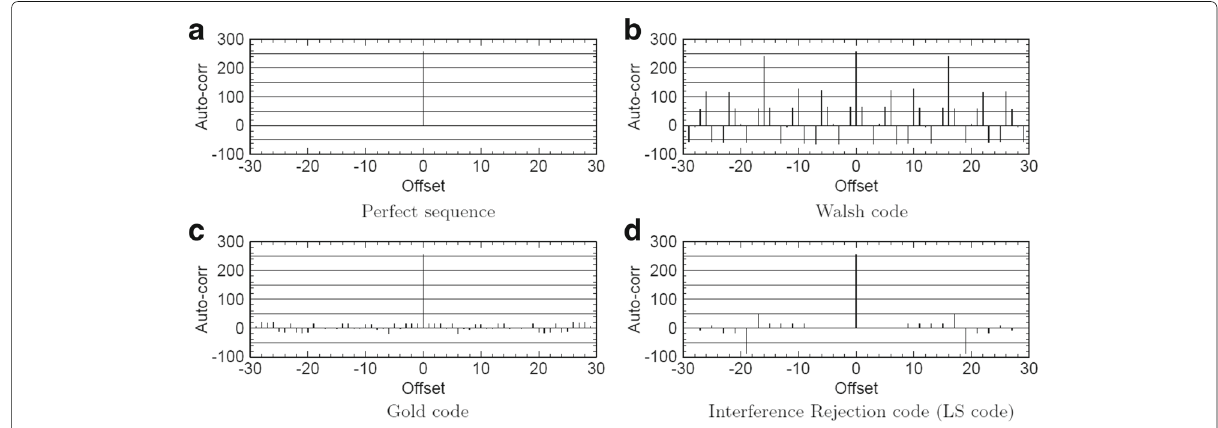
Fig. 1 Cross-correlations of four different codes. a Perfect sequence. b Walsh code. c Gold code. d Interference rejection code (LS code)